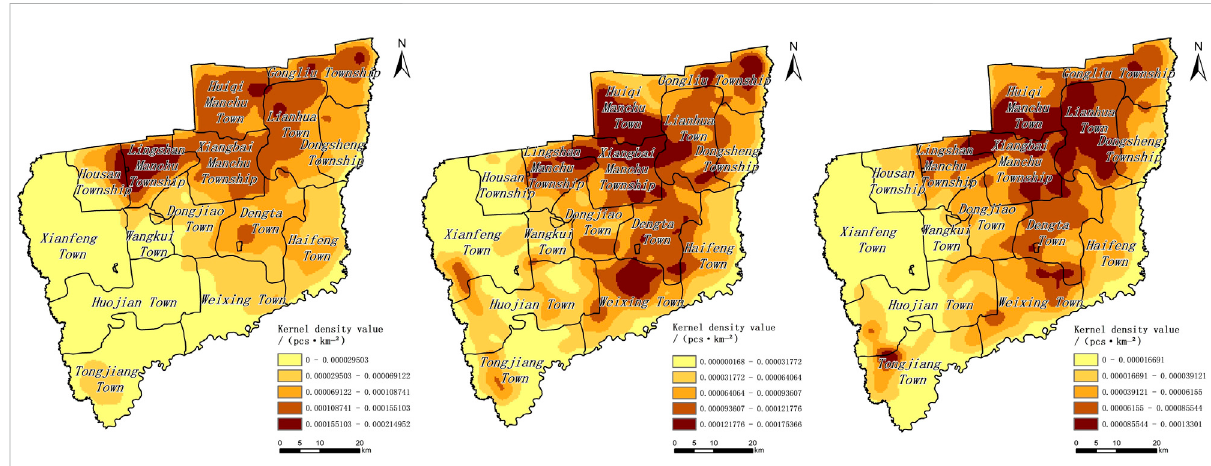
FIGURE 12 Spatial distribution characteristics and evolution of maize – soybean rotation pattern.